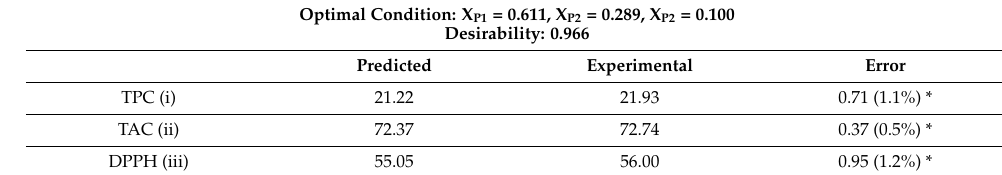
Table 4. Verification experiments under optimal conditions.